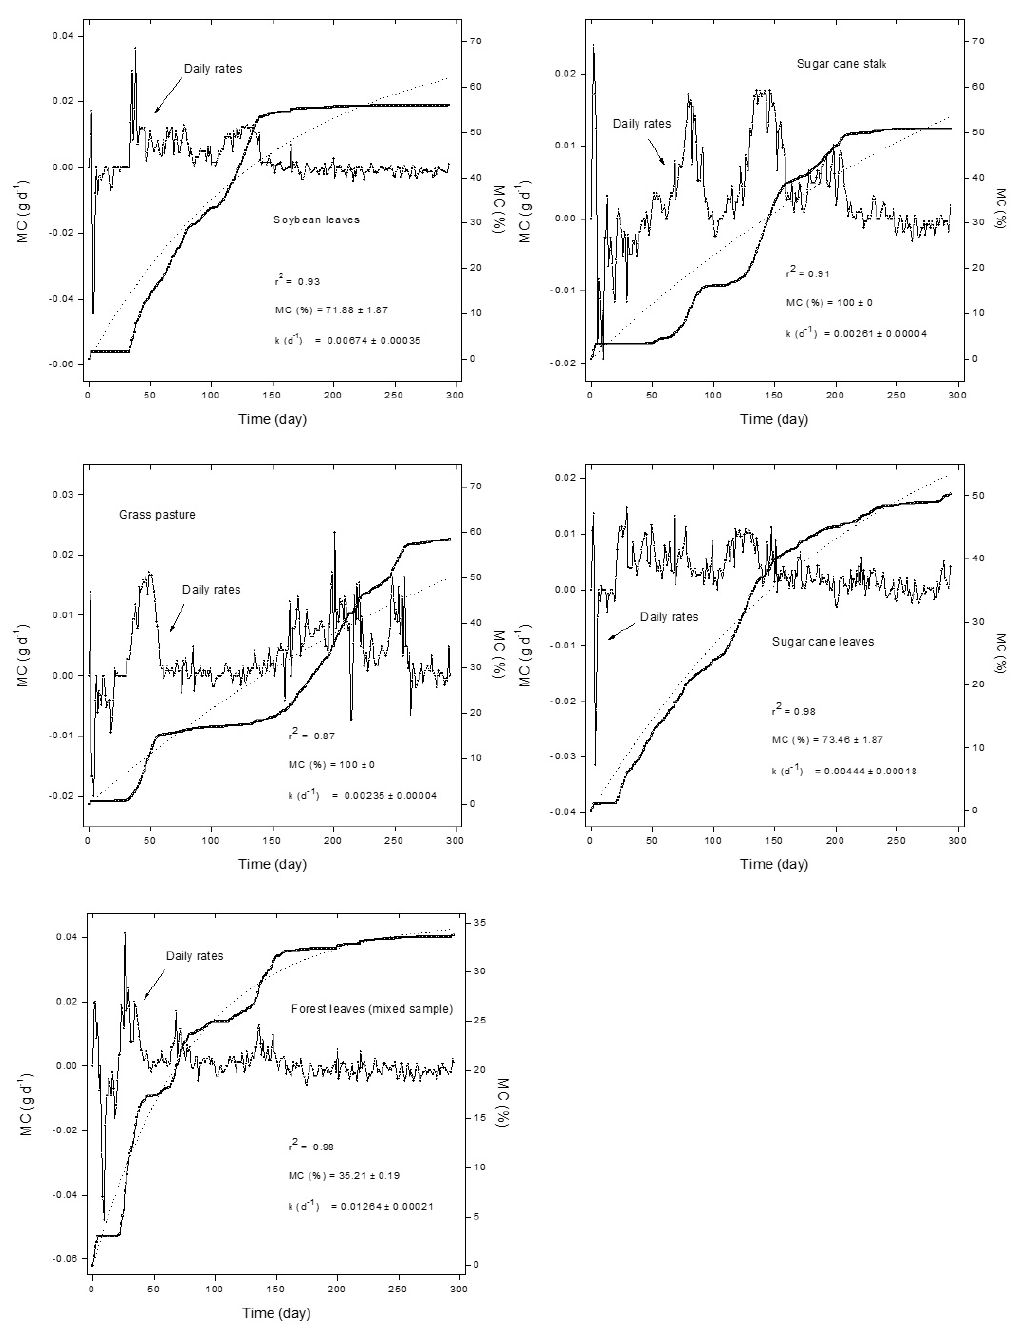
Figure 3. Mineralization daily rates, accumulated MC (points: experimental results; dotted lines: model results) during anaerobic decomposition, under aquatic media of soybean leaves, sugar cane stalks, grasses, sugarcane leaves and mixed samples of forest leaves. The kinetic parameters (MC and k) and the determination coefficient (r 2 ) from the kinetic fittings are also